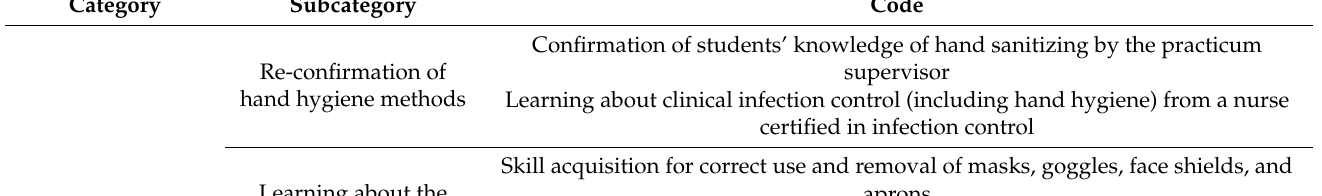
Table 1. Categories relating to nursing student awareness of IPMs for practicums during the COVID-19 crisis.